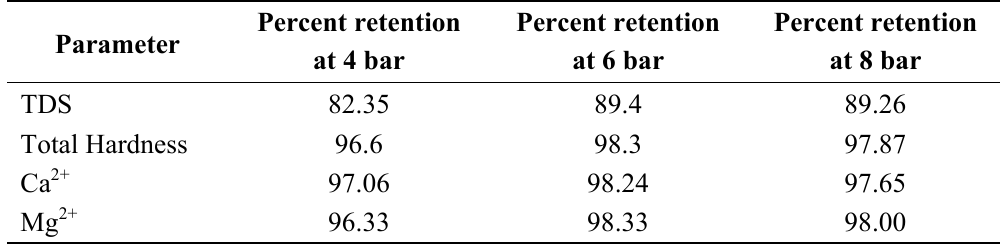
Table 6. Retention percentage (% R ) of TDS, total hardness, Ca 2+ and Mg 2+ at various pressures for Sample 3.